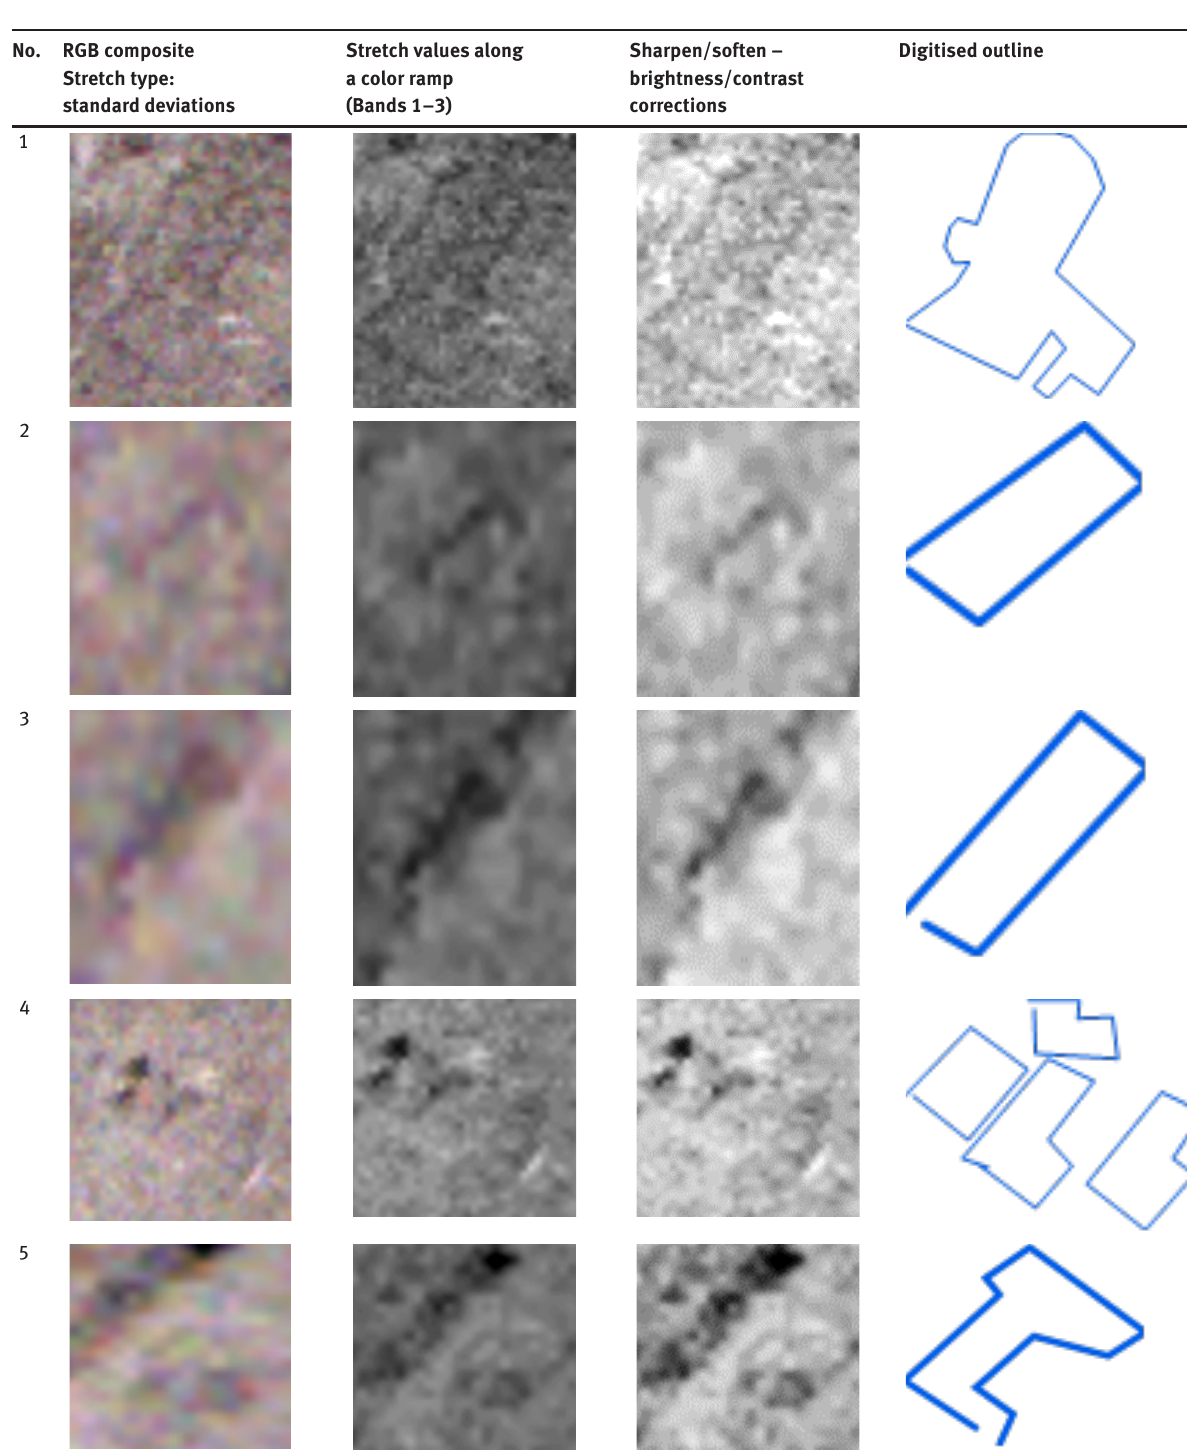
Table 2: Indicative examples of archaeological proxies’ interpretation, after image enhancement. These proxies were detected on the 1968 aerial